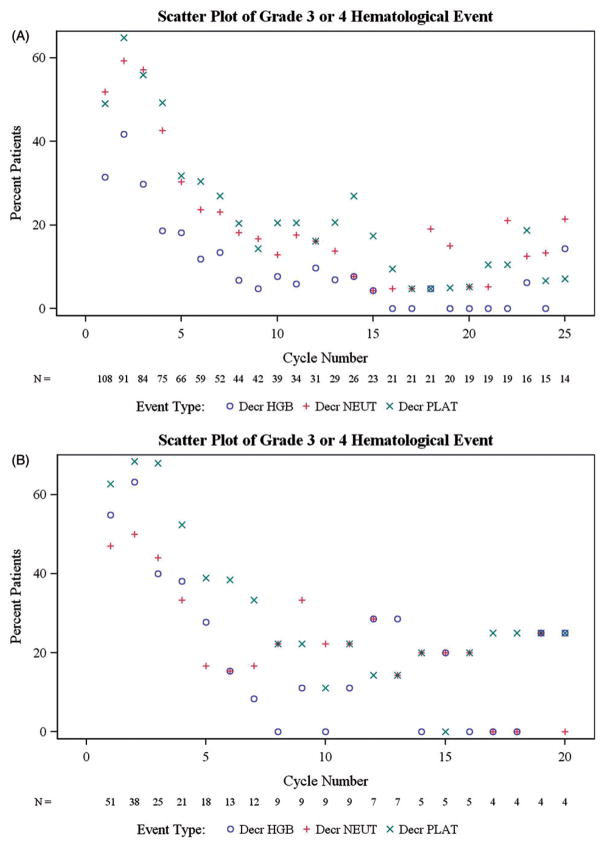
Proportion of chronic-phase patients (A) and accelerated-phase patients (B) experiencing grade 3/4 hematologic toxicity (anemia, neutropenia, and thrombocytopenia) by cycle.